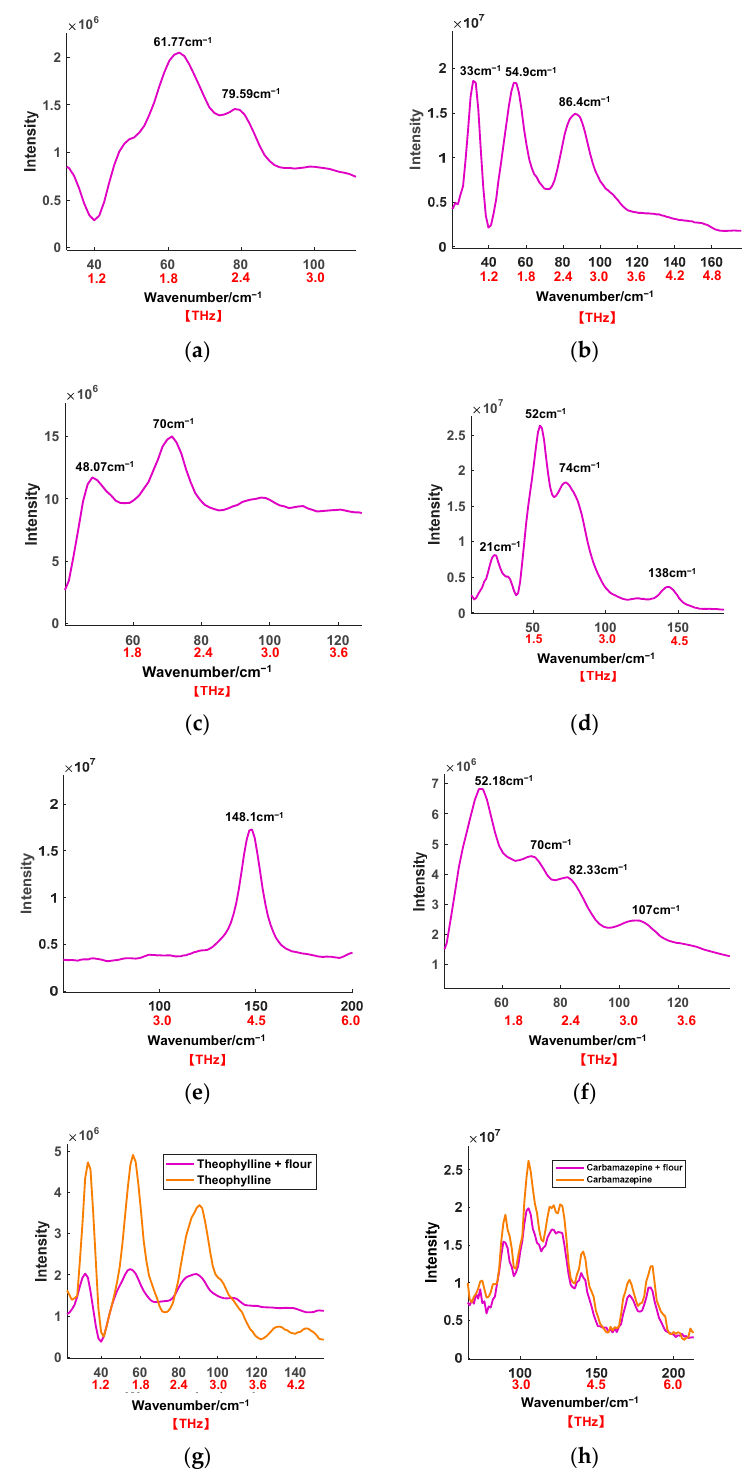
Figure 5. ( a ) Terahertz Raman spectrum of furantoin; ( b ) terahertz Raman spectrum of Tylenol; ( c ) terahertz Raman spectrum of indomethacin; ( d ) terahertz Raman spectrum of ibuprofen; ( e ) terahertz Raman spectrum of cold medicine tablet; ( f ) terahertz Raman spectrum of painkiller tablet; ( g ) comparison of terahertz Raman spectra of theophylline; ( h ) comparison of Terahertz Raman spectra of